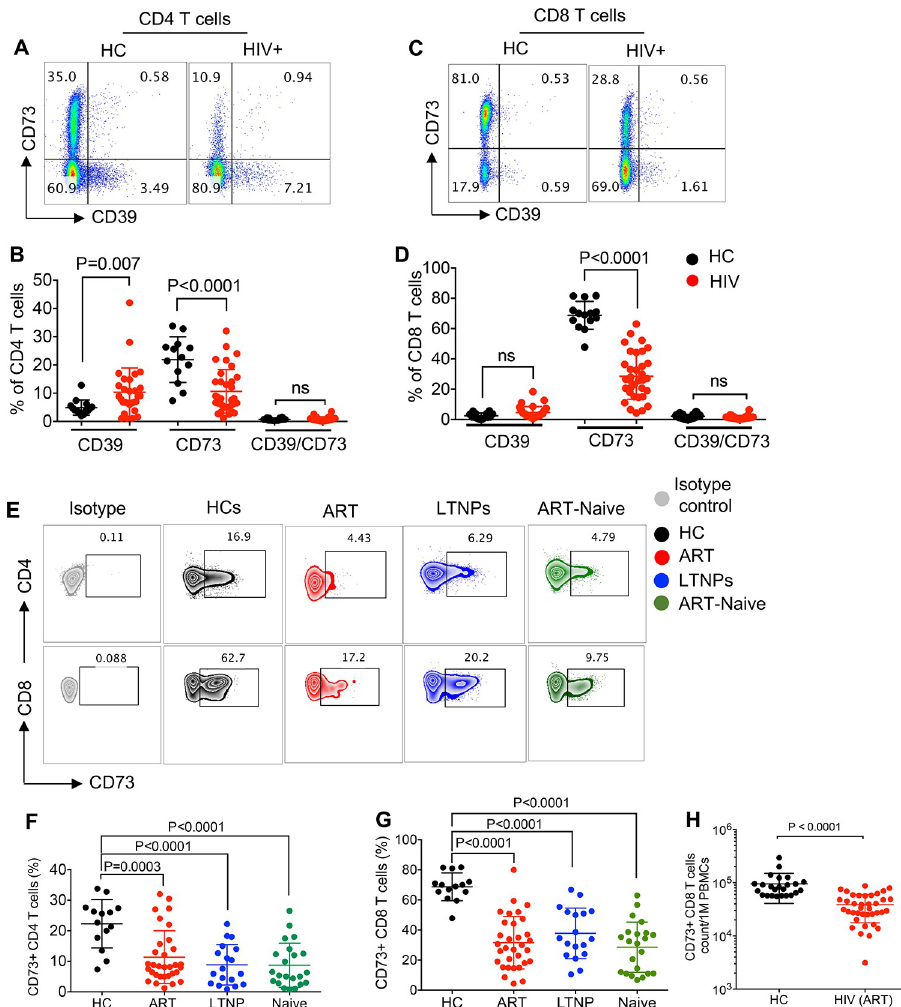
Fig 1. Lower frequency of CD73 + T cells in the peripheral blood of HIV-infected individuals. ( A ) Representative flow cytometry plots, and ( B ) Cumulative data showing percentages of CD39 + and CD73 + CD4 + T cells in healthy controls (HCs) versus HIV-infected individuals. ( C ) Representative flow cytometry plots, and ( D ) Cumulative data showing percentages of CD39 + and CD73 + CD8 + T cells in HCs versus HIV-infected individuals. ( E ) Representative flow cytometry plots, ( F ) Cumulative data showing percentages of CD73 + CD4 + T cells, and ( G ) CD73 + CD8 + T cells in HCs compared to HIV-infected individuals either on ART, ART-naive or LTNPs. ( H ) Cumulative data of total CD73 + CD8 + T cells in PBMCs of HCs and HIV-infected individuals on ART. Each point represents one human subject either HC or HIV-infected individual. Data are obtained from multiple independent experiments. Each dot represents data from an individual human subject. Statistical analysis determined by the Mann-Whitney U-test (B, D, F-H) with significance indicated. ns: no significant.